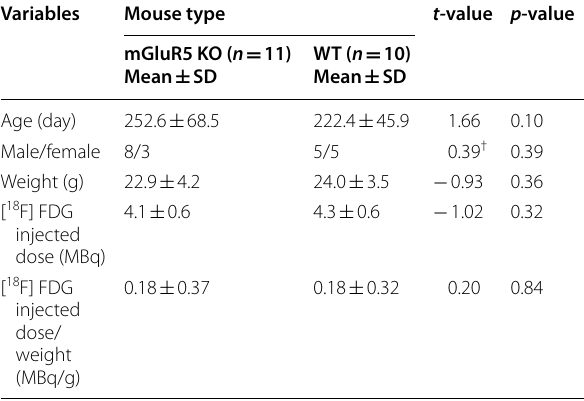
Table 1 Demographic characteristics and scan parameters